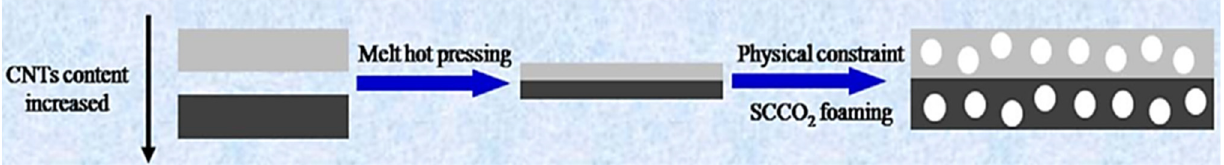
Figure 4. Schematic of PMMA/CNT laminated nanocomposite foam preparation [53]. PMMA/CNT = poly(methyl methacrylate)/carbon nanotube; SCCO 2 = supercritical carbon dioxide. Reproduced with permission from Elsevier.